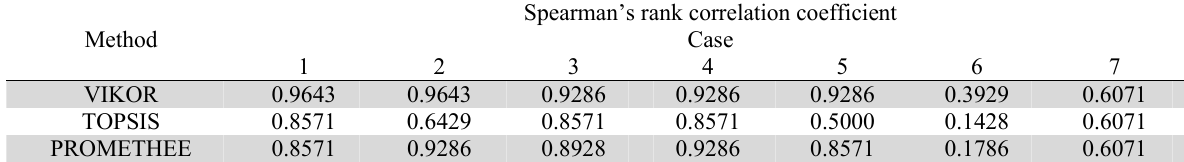
Spearman’s rank correlation coefficient values for Example